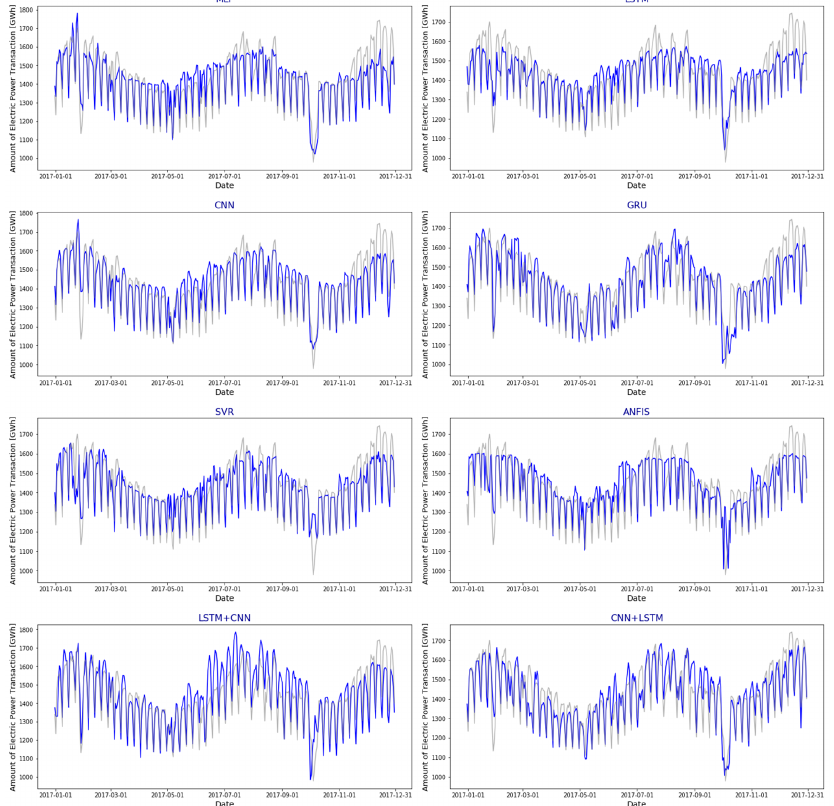
Figure 28. Comparison of seasonal patterns with different algorithms.